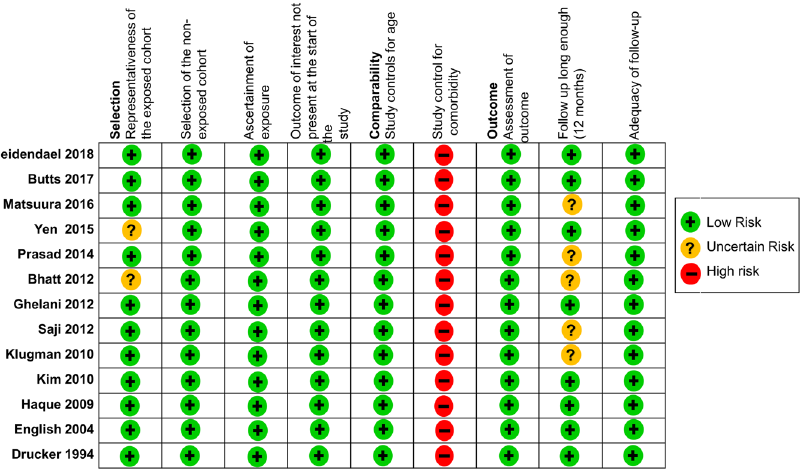
Figure 2. Risk of bias assessments for cohort